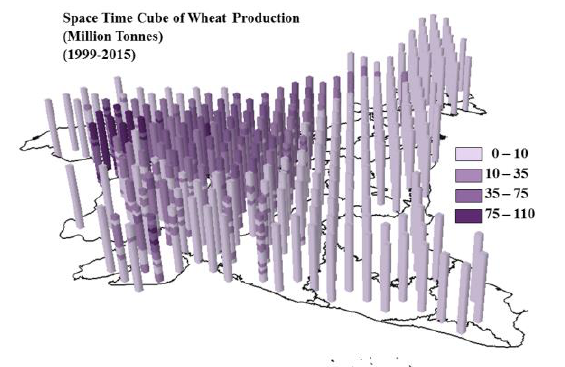
Figure 10 Space time cube of wheat crop production in Figure 8 . Diminishing hot spot coincide with the Thar Desert regions of Rajasthan and the saline marshy regions of Gujarat